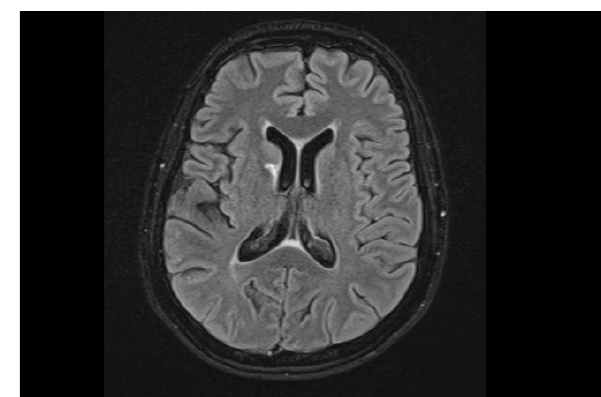
Fig. 1a. Axial T1-weighted MRI scan, showing contrast-en- hanced lesion in the periventricular region of the right tem- poral lobe.